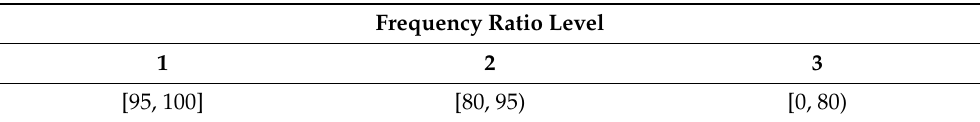
Table 4. Frequency Ratio Classification